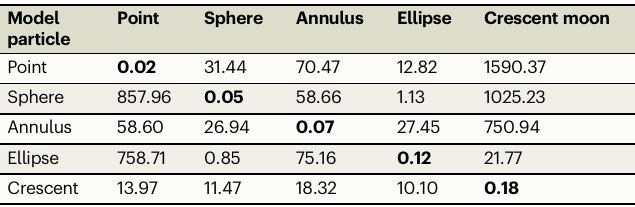
Table 1 | LodeSTAR has discriminative